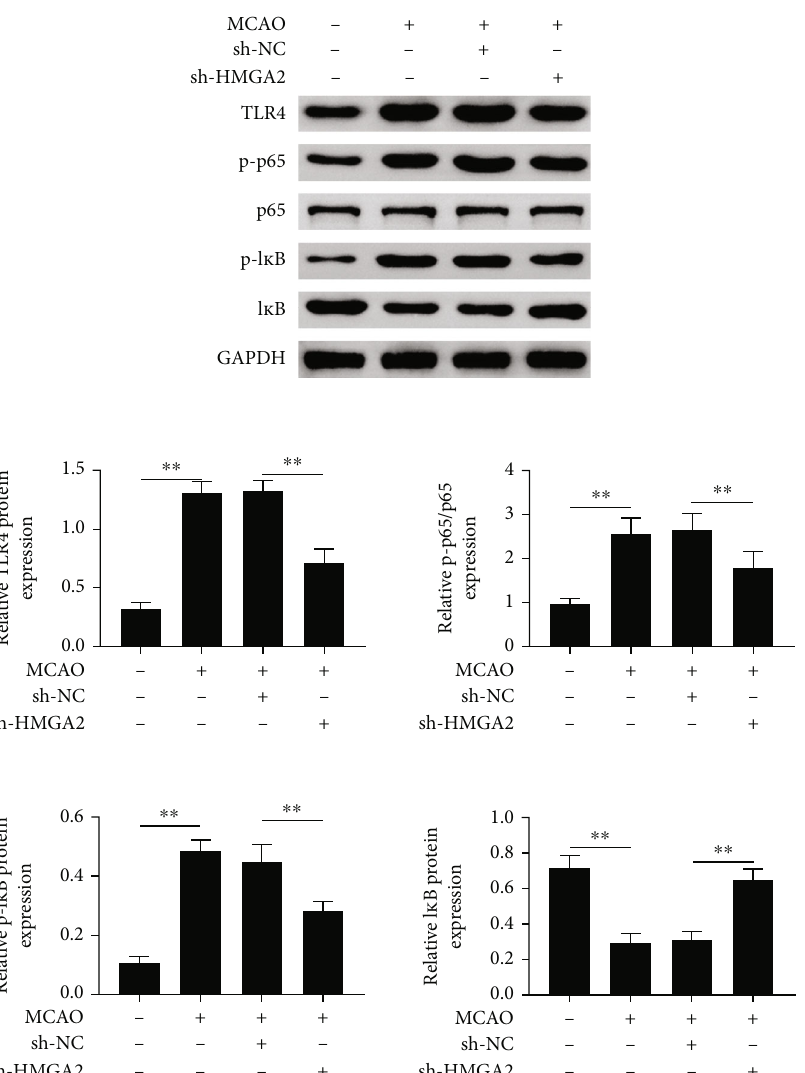
Figure 4: The e ff ects of HMGA2 on TLR4/NF- κ B signaling pathway activation in cerebral infarction rats. Western blot analysis of protein expression in the TLR4/NF- κ B signaling pathway after sh-HMGA2 or sh-NC transfection. ∗∗ p < 0 : 01 vs. sham or MCAO + sh-NC. Data are expressed as mean ± SEM